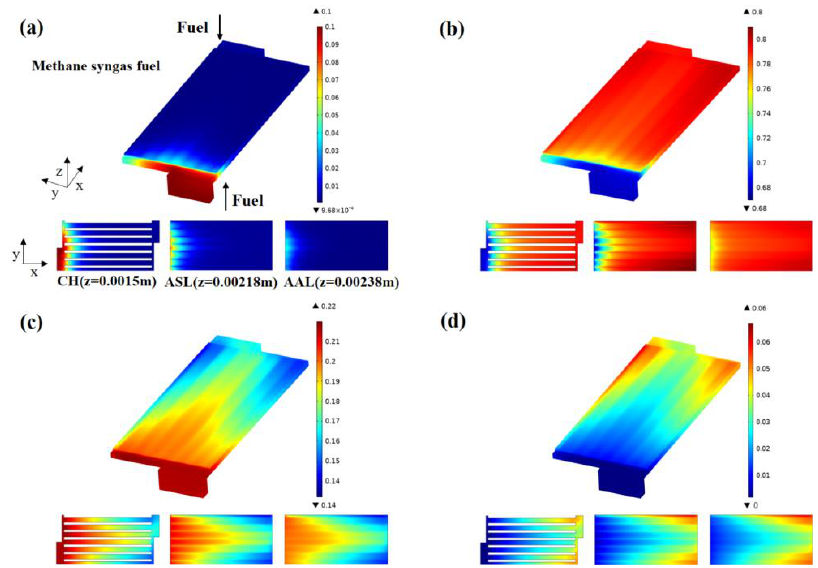
Figure 6. Molar fractions of methane syngas SOFC for: ( a ) H 2 ; ( b ) H 2 O; ( c ) CH 4 ; ( d ) CO.